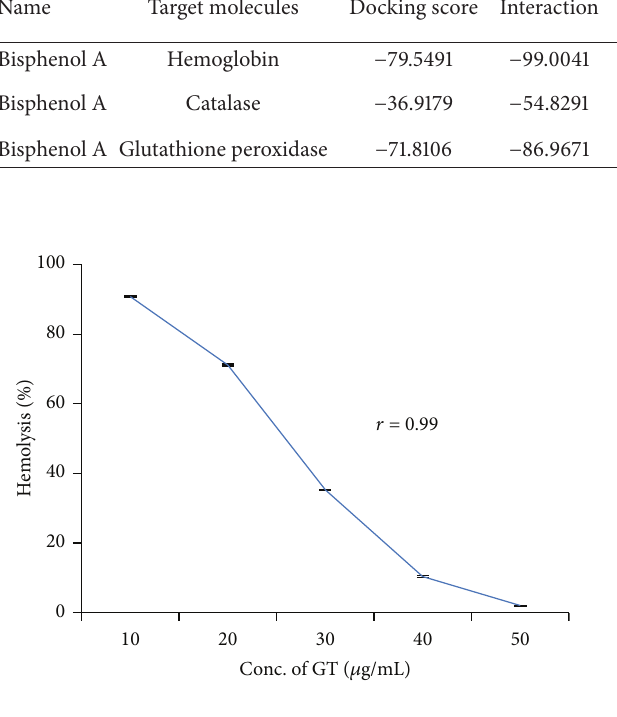
Figure 3: Retardation in bisphenol A-induced hemolysis by green tea extract. Results are expressed as mean ± SEM; 𝑛 = 10 . ∗ Significant at the level 𝑃 < 0.05 as compared to control.